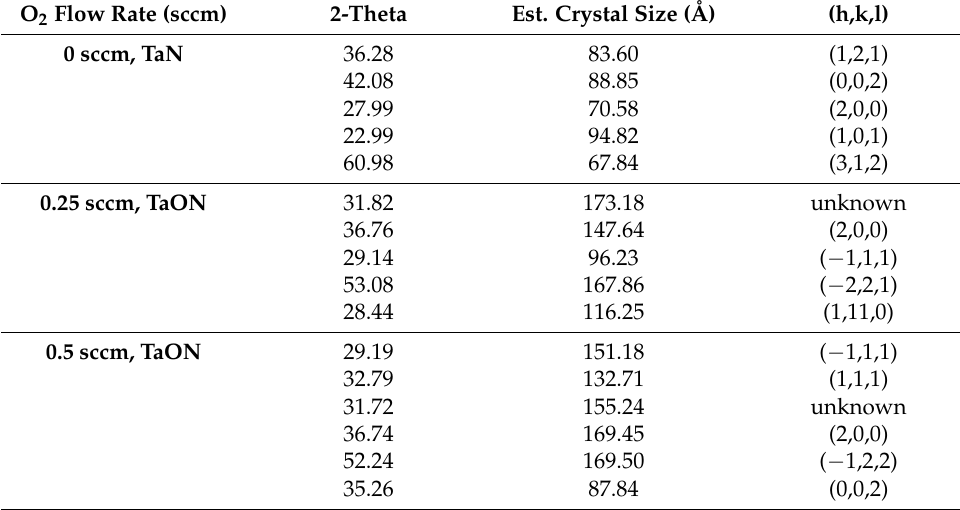
Table A1. Estimated crystal size for major peaks in XRD. O 2 Flow Rate